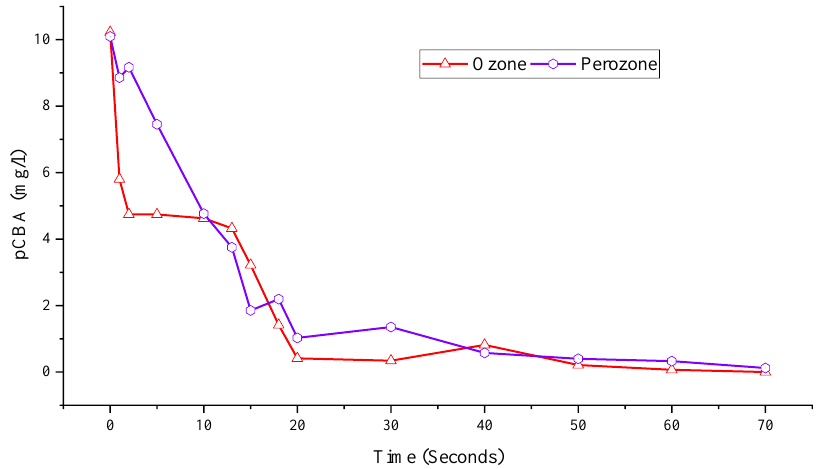
Figure 7. p CBA concentration with respect to ozone sparging time.